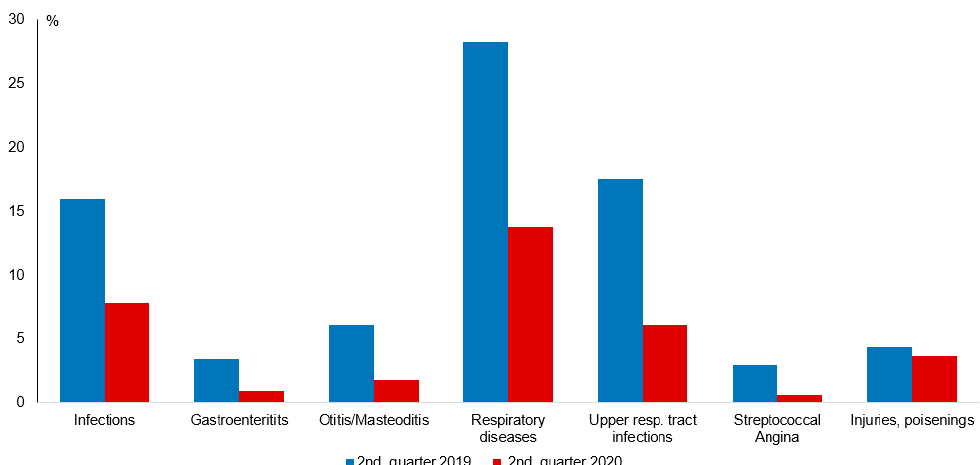
Figure 1. Frequency of diagnosed acute physical illnesses (% of all children) in children aged 1–12 years in the 2nd quarters of 2019 (control) and 2020 (COVID-19 pandemic).